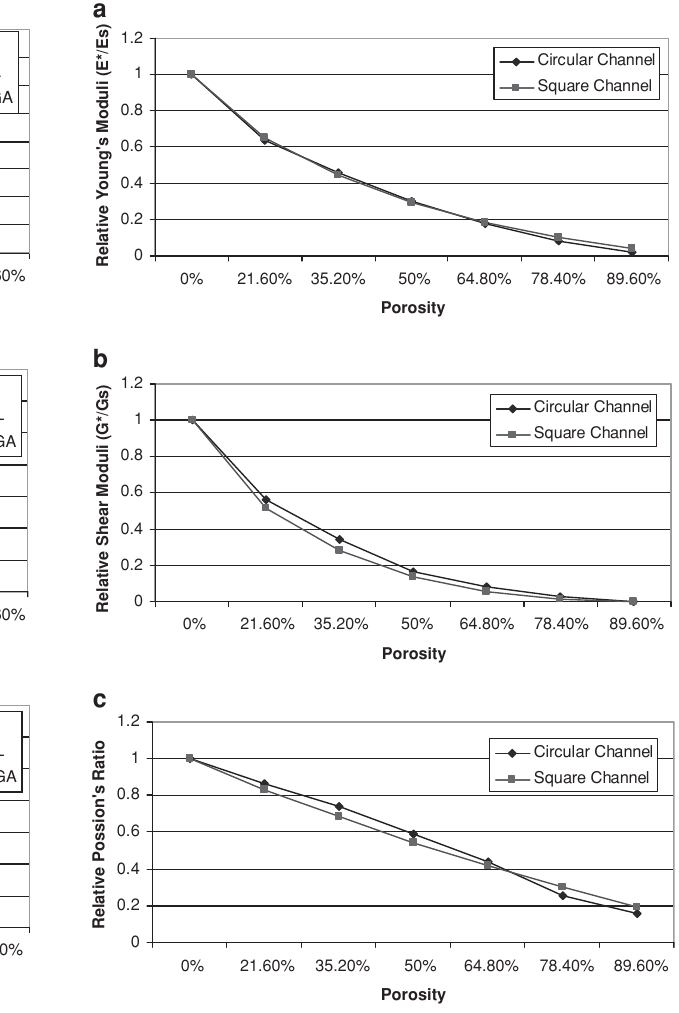
Figure 7 Comparisons of the scaffold relative elastic constants: (a) Young’s modulus, (b) shear modulus and (c) Poisson’s